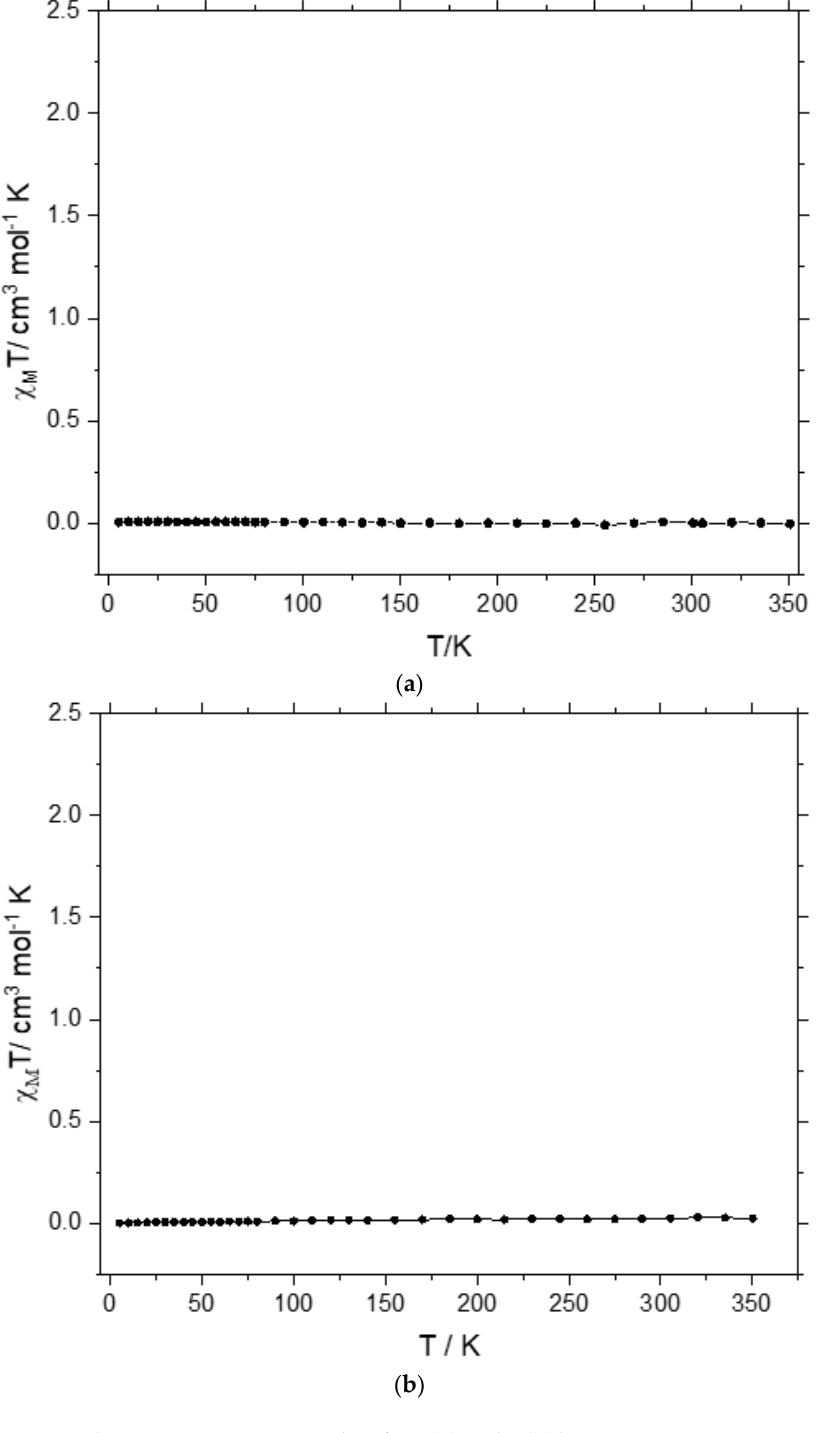
Figure 3. The χ M T vs. T magnetic plots for 1 ( a ) and 2 ( b ) between 5–350 K.